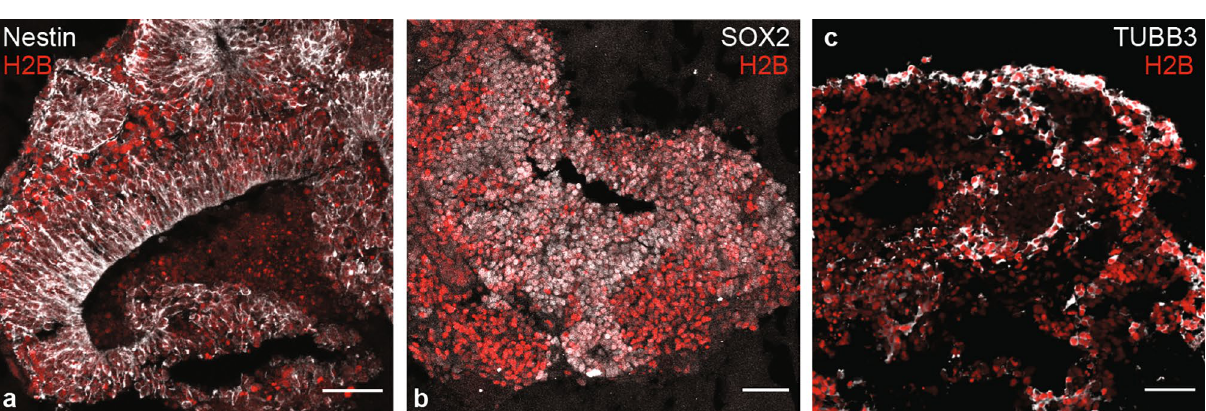
Figure 3. Confocal microscopy images of cryo-sections of the stem cell derived neuron culture. The presence of Nestin ( a ) and SOX2 ( b ) within rosette-like structures are signatures for neural progenitors (SOX2) and neuroepithelial cells (Nestin), respectively 46–49 . Both cell-specific markers are present in neurosphere cultures 50,51 as well as retinal neurospheres 52 . ( c ) Class 3 ß-tubulin (TUBB3) binds microtubules in neurons and is also present in neurospheres 51,53 . Scale bar: 50